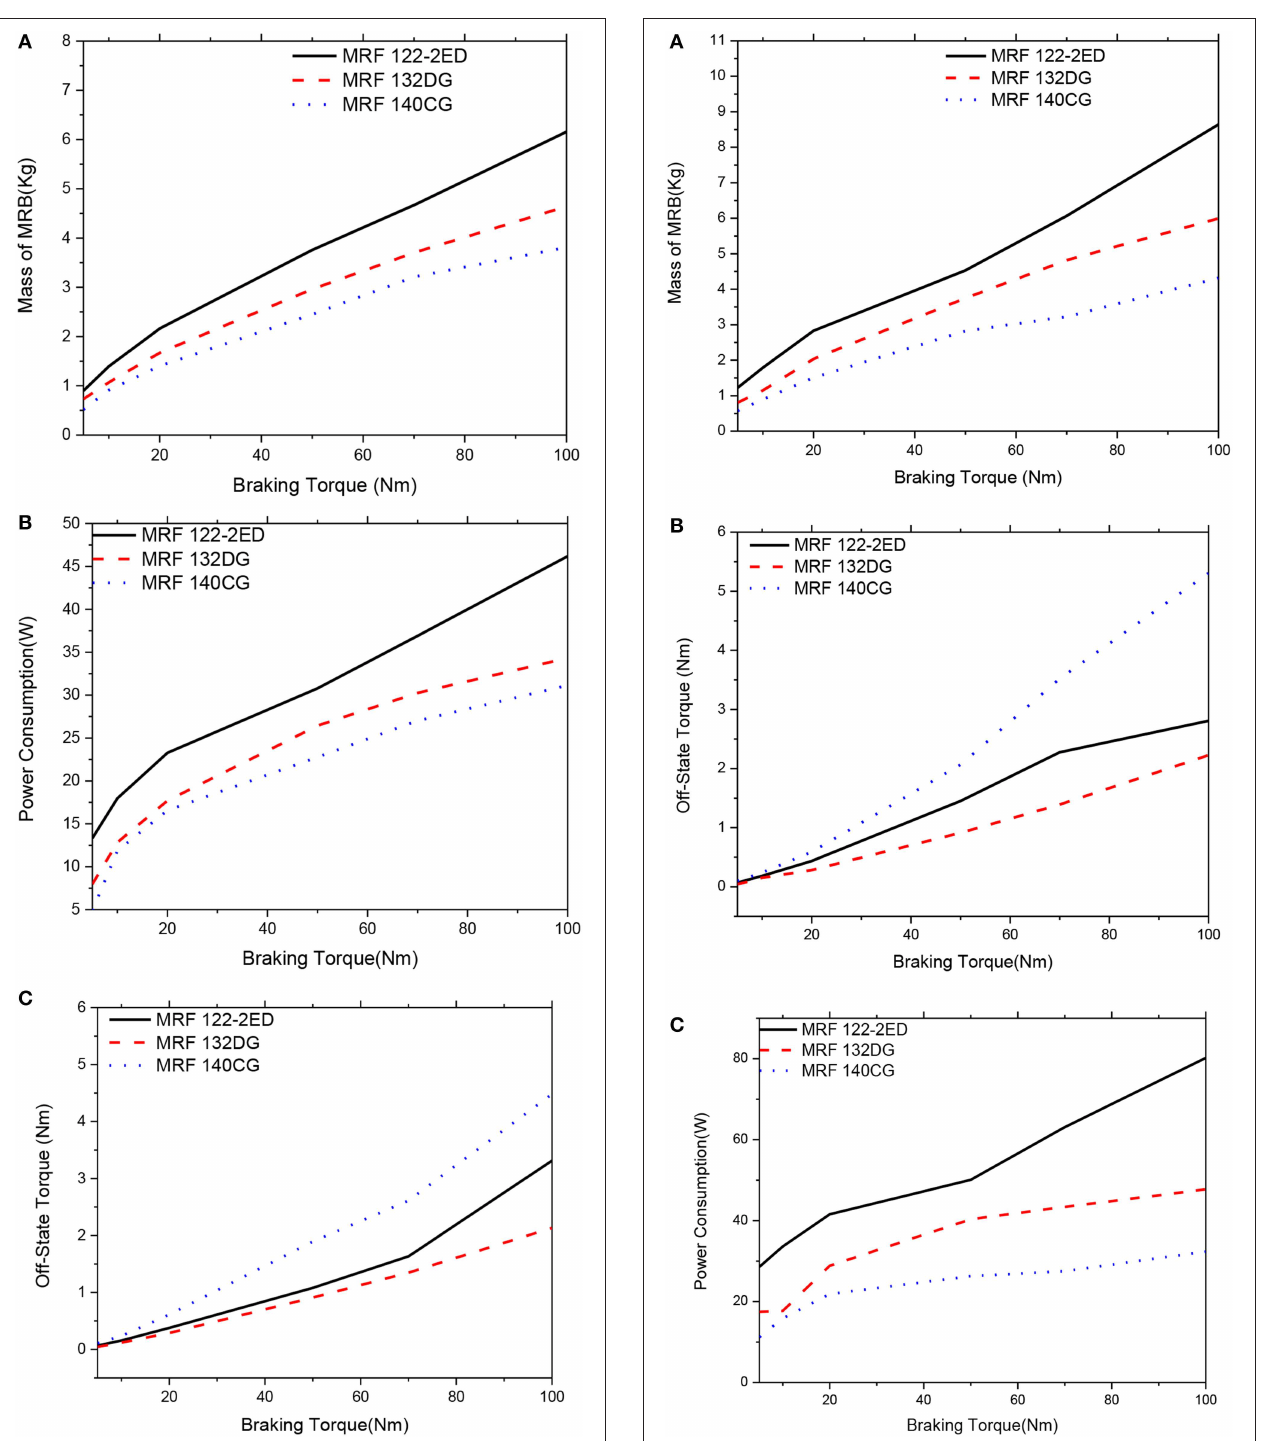
Frontiers in Materials |